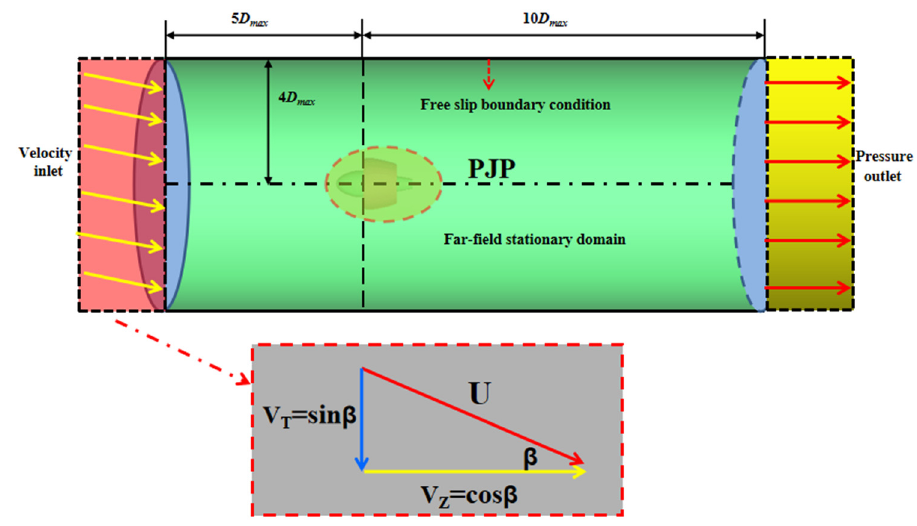
Figure 2. Computational domain and boundary conditions. The red arrows represent one interpre- tation of the velocity inlet.